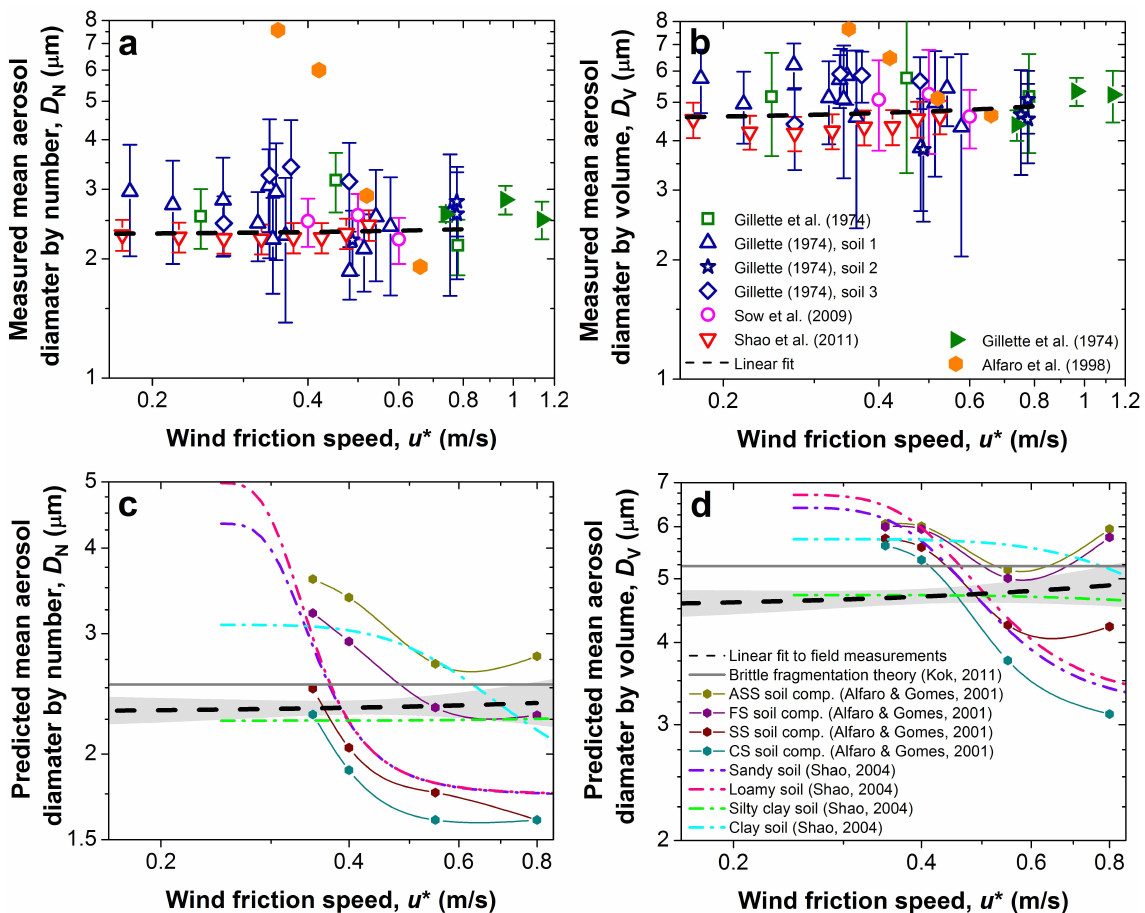
Fig. 2. Dependence of the mean dust aerosol diameters by number (a) and volume (b) on the wind friction speed. Wind tunnel and field measurements are respectively denoted by filled and open symbols. Linear least-squares fits to the compilation of all field measurements (black dashed lines) show trends of the mean aerosol diameter with u ∗ that are within one standard error (Table 1), and are thus statistically insignificant. Linear fits to individual data sets are also reported in Table 1. Panels (c) and (d) respectively show the mean aerosol diameter by number and volume predicted by theoretical dust emission models. Plotted for comparison are the linear fits to the measurements from (a) and (b) ; the shading denotes the uncertainty on the fit, which is calculated as described in the supplementary text. Parameters required for the brittle fragmentation theory (solid grey line) were obtained from Kok (2011). The models of Alfaro and Gomes (2001) (solid lines and hexagons) and Shao (2004) (dash-dotted lines) require detailed soil size distribution information, which is not available for most of the data sets of the size-resolved vertical dust flux. Nonetheless, mean dust aerosol diameters were calculated from Eq. (1) for several “typical” arid soils, which thus do not necessarily correspond to any of the soils for which measurements of the emitted dust PSD were made. For Alfaro and Gomes (2001), D N and D V were calculated from the theoretical emitted dust PSD reported for four values of u ∗ in their Table 5. The increase in D N and D V at u ∗ =0.80ms − 1 for several of the soils is inconsistent with the assumption in Alfaro and Gomes (2001) that higher wind speeds produce more disaggregated aerosols and might be due to numerical errors in the production of their Table 5 (Grini et al., 2002). For Shao (2004), D N and D V were obtained by inserting the four soil size distributions reported in his Table 1 into his Eq. (6) , and using a threshold u ∗ for erosion of 0.25ms − 1 , consistent with the thresholds reported in the experimental data sets used here (Table